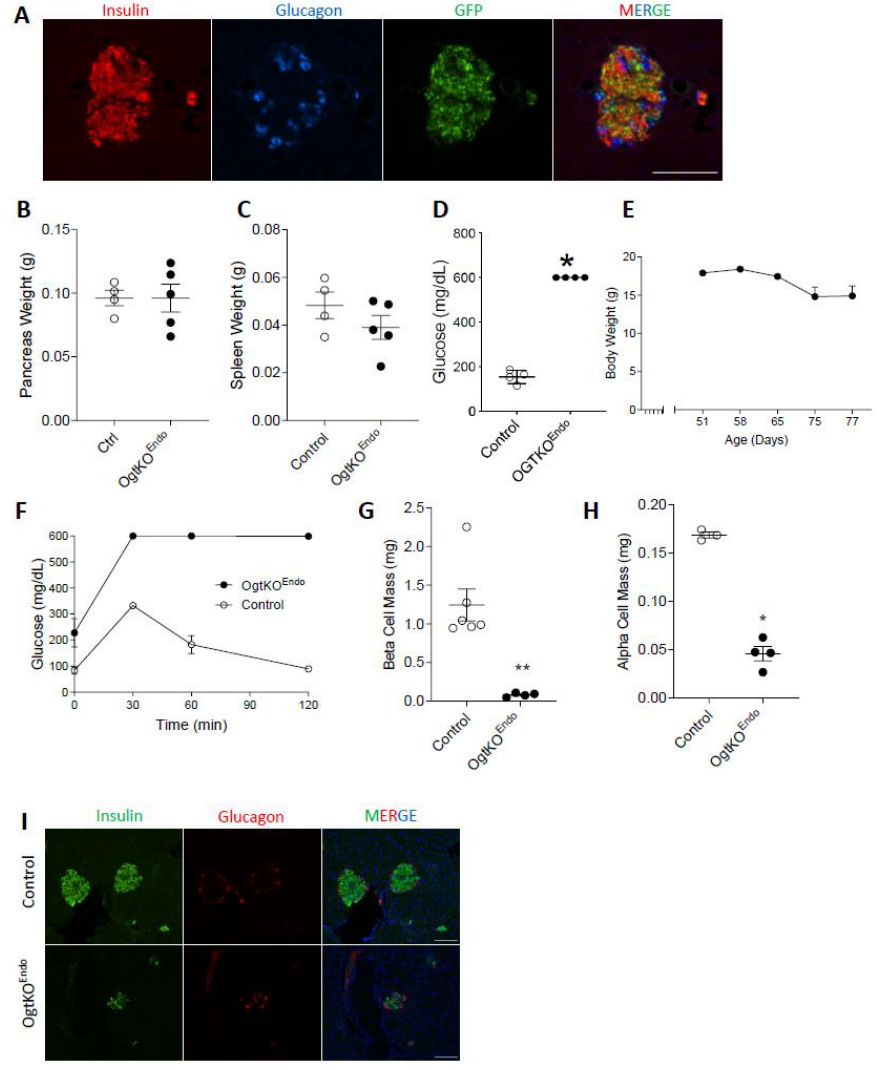
Figure 4. Severe glucose intolerance and loss of β -cell mass in male OgtKO Endo . Representative image of OgtKO Endo at p137 showing robust GFP cre-reporter expression ( A , 20 × , scale = 100 µ m). Pancreas weight ( B ), and spleen weight ( C ) at p60. Non-fasting blood glucose levels ( D ), body weight progression ( E ), and glucose tolerance test ( F ) at p60. Quantification of β -cell mass ( G ) and α -cell mass ( H ) showing severe reduction in OgtKO Endo at p60. Representative immunofluorescence images of islets at p60 ( I , 20 × , scale = 100 µ m). Statistics were performed with a Mann–Whitney U-Test (two-tailed with significance p ≤ 0.05; * p ≤ 0.05, ** p ≤ 0.01). In all graphs, open circle = Control and closed circle = OgtKO Endo